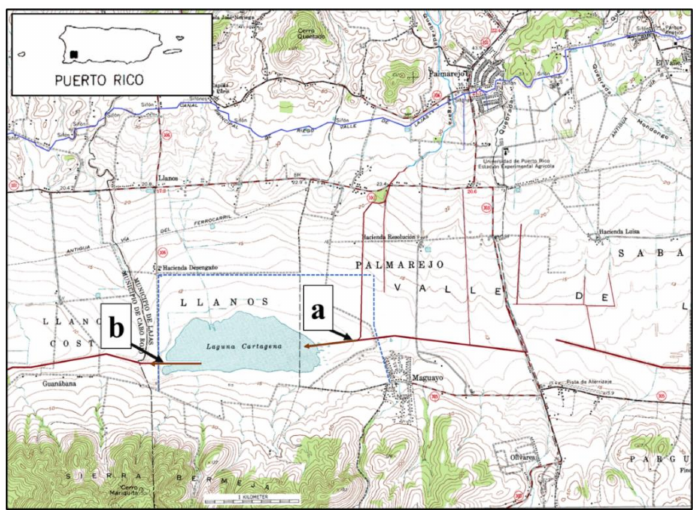
Figure 1. Location of Laguna Cartagena (USGS (US Geological Survey) San German Quadrangle). The shaded area denotes the water surface level (the 10 m contour) at the time of the 1982 update. ( a ) Inlet to the lagoon (combined inlet canal, the Principal Drainage Canal adjacent to the town of Magüayo and ( b ) the outlet (exit canal) within the lagoon. The dashed blue line indicates the jurisdictional limits of the National Wildlife Refuge around the